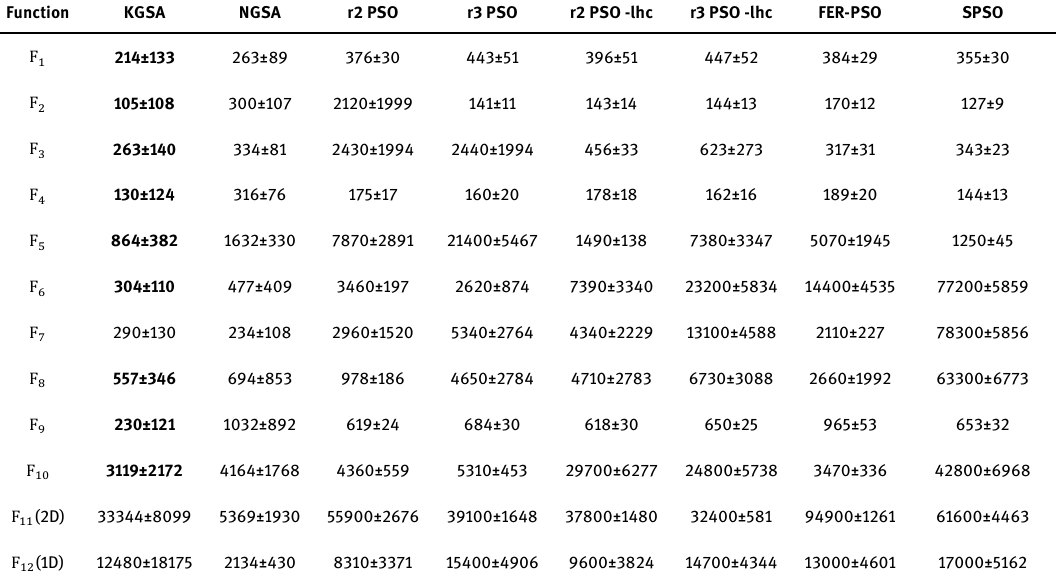
Table 3A: Mean value of fitness function assessments needed to converge for each PSO based algorithm for the results shown in Table 1. The results were averaged over fifty independent runs of algorithms